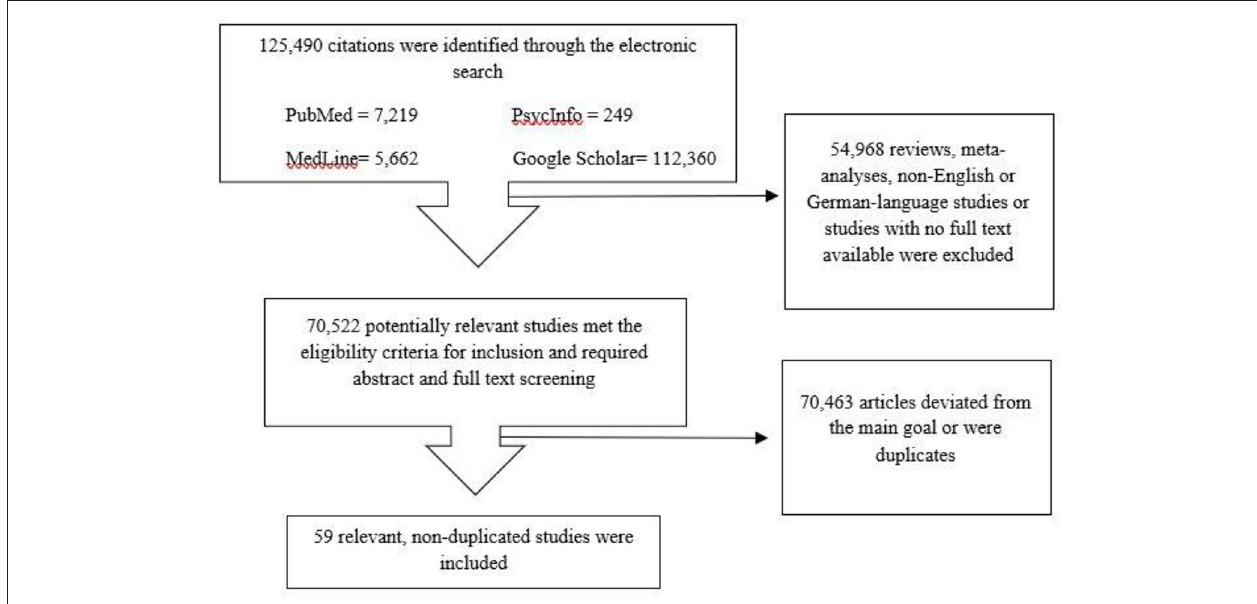
FIGURE 1 | Flowchart for article screening and